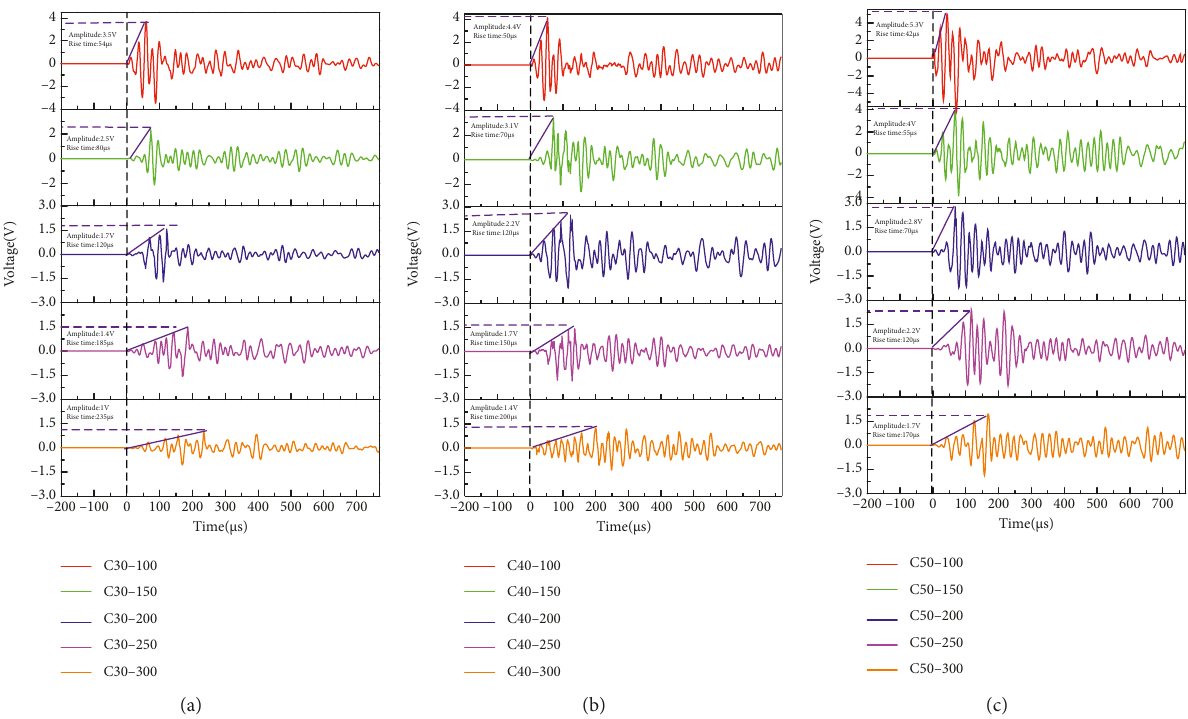
Figure 10: Time domain spectra of acoustic emission signals in concrete with strength grade. (a) C30, (b) C40, and (c) C50.